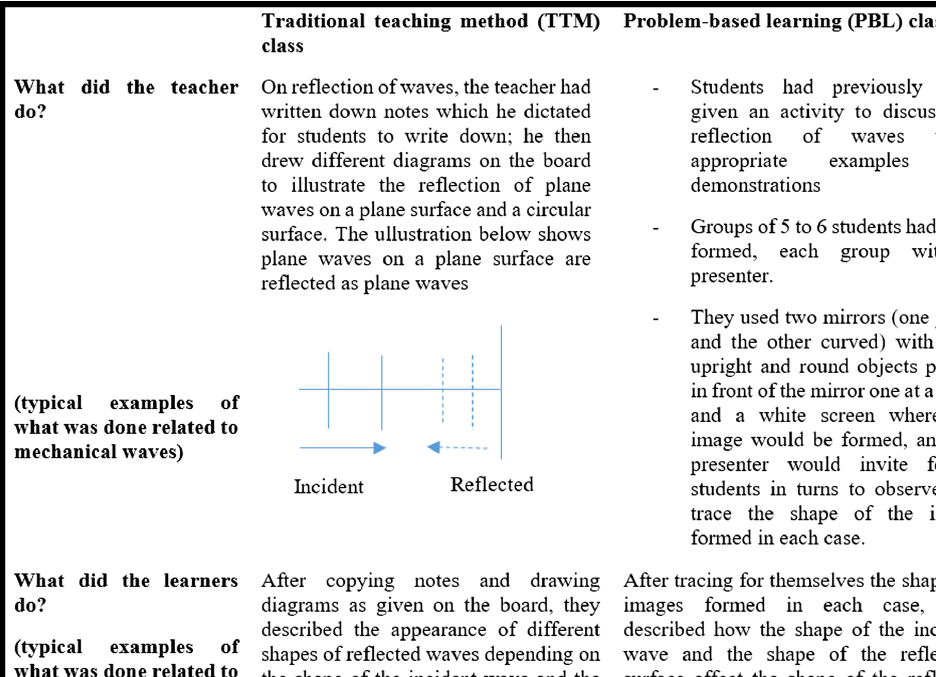
FIG. 1. Intervention